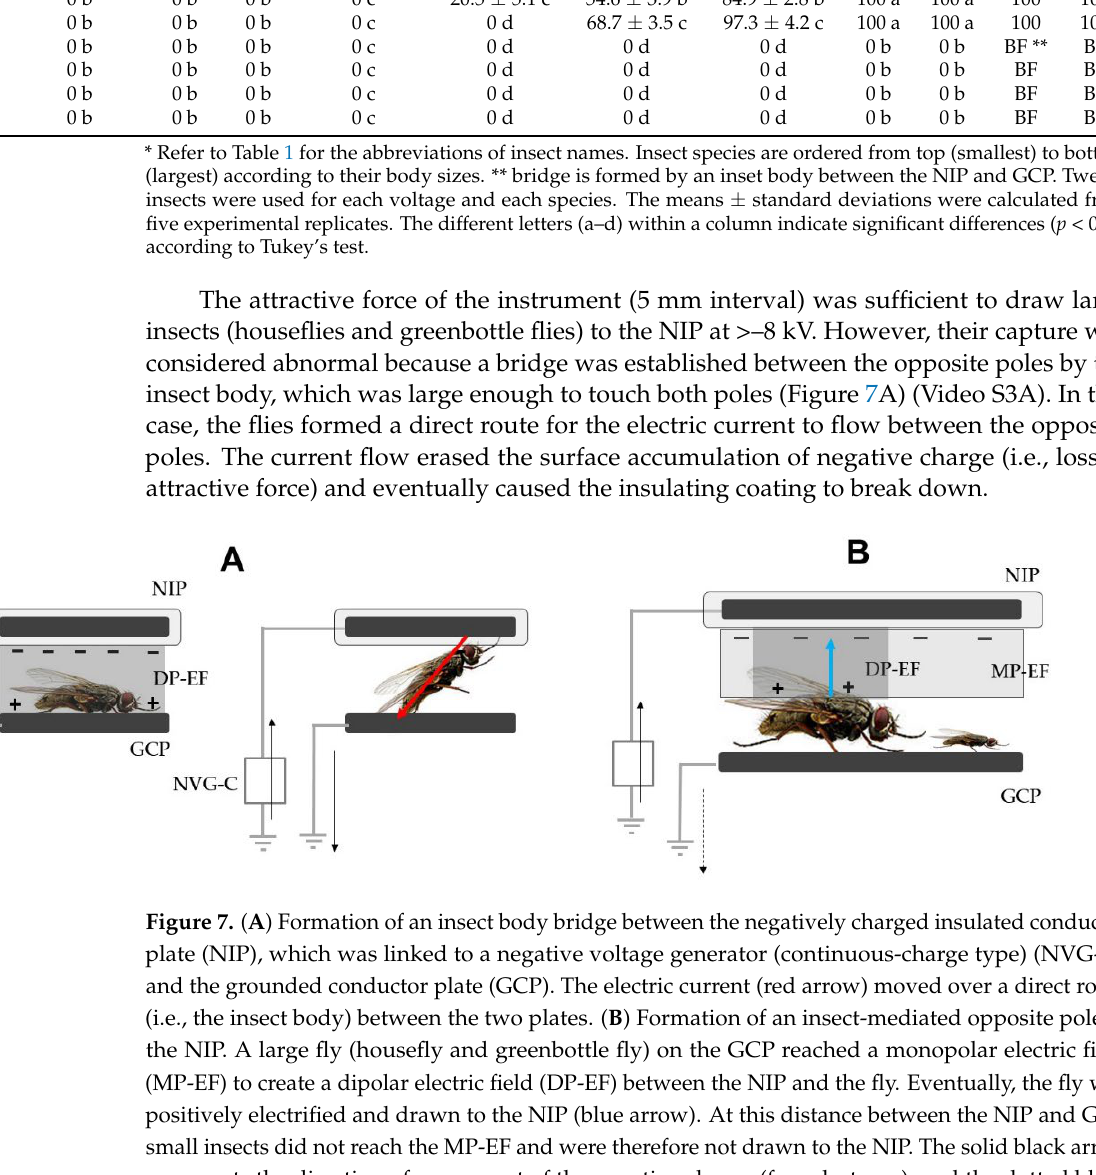
Figure 7. ( A ) Formation of an insect body bridge between the negatively charged insulated conductor plate (NIP), which was linked to a negative voltage generator (continuous-charge type) (NVG-C), and the grounded conductor plate (GCP). The electric current (red arrow) moved over a direct route (i.e., the insect body) between the two plates. ( B ) Formation of an insect-mediated opposite pole to the NIP. A large fly (housefly and greenbottle fly) on the GCP reached a monopolar electric field (MP-EF) to create a dipolar electric field (DP-EF) between the NIP and the fly. Eventually, the fly was positively electrified and drawn to the NIP (blue arrow). At this distance between the NIP and GCP, small insects did not reach the MP-EF and were therefore not drawn to the NIP. The solid black arrow represents the direction of movement of the negative charge (free electrons), and the dotted black arrow represents an insect-derived transient electric current caused by its positive